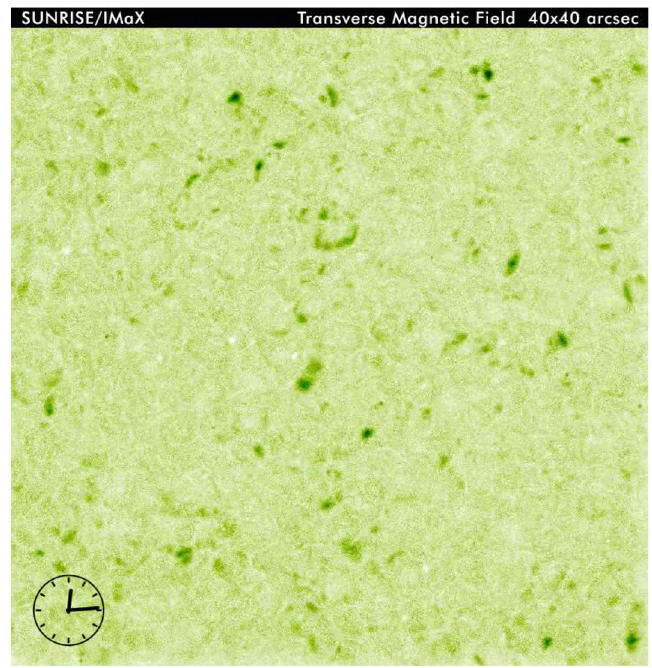
Fig.12 StillfromamovieshowingthelinearpolarizationsignalsobservedbySUNRISE/IMaXintheINon 9June2009.Thesequencehasatotaldurationof32minandacadenceof30s.TheFOVmeasures40 (cid:2)(cid:2) × 40 (cid:2)(cid:2) with a pixel size of 0 . 055 (cid:2)(cid:2) . More details can be found in Solanki et al. (2010). Courtesy V. Martínez Pillet and the SUNRISE team. (For movie see Electronic Supplementary